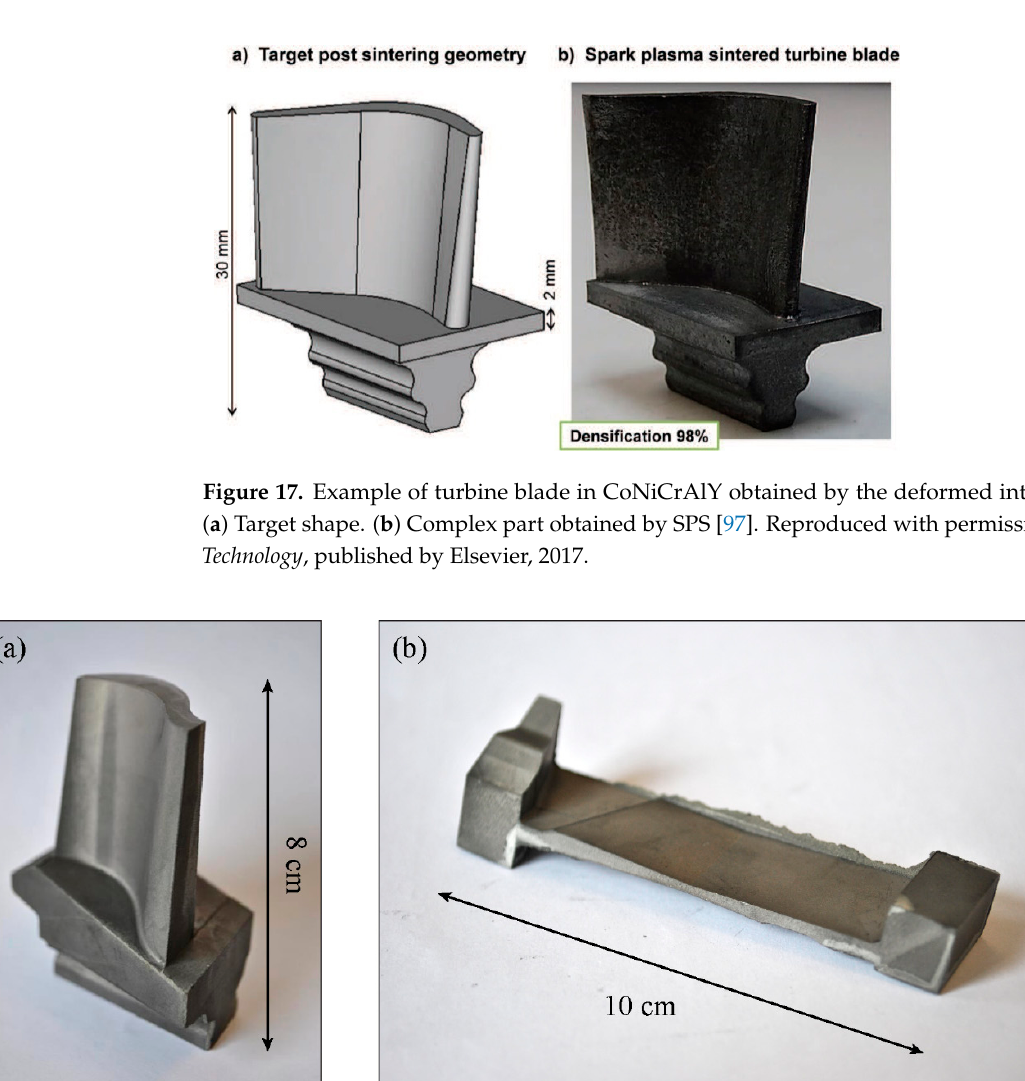
Figure 18. Turbine blade preforms in TiAl ( a ) 8 cm in height [32], and ( b ) 10 cm long [98], shaped by SPS. Reproduced with permission from Advanced Engineering Materials , published by John Wiley and Sons, 2015, and from Springer eBook , published by Springer Nature, 2019.